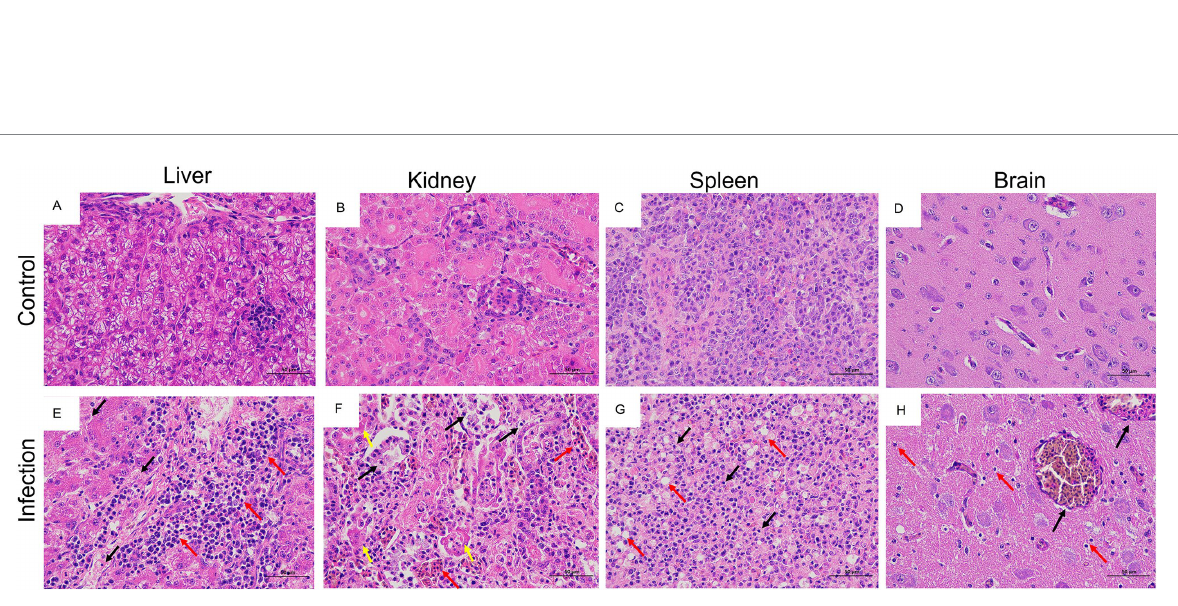
FIGURE 8 Histopathological changes in goslings, naturally infected and experimentally infected with GoAstV-GD2101. (A–D) Healthy liver, kidneys, spleen, and brain from the control group. (E) A slight loosening of hepatocyte cytoplasm (black arrow) and hepatocyte swelling (red arrow; H&E). (F) Severe exfoliation of renal tubular epithelial cells (black arrow), increased eosinophilia of the cytoplasm and a lumen filled with urate deposits (yellow arrow), small area of renal tubulointerstitial stasis dilatation (red arrow; H&E). (G) The nuclei of the spleen cells were pyknotic, deeply stained, or fragmented (black arrow), along with a large number of macrophages red arrow; H&E). (H) Limited congestion and dilation of blood vessels in the brain (black arrow) and diffuse proliferation of microglial cells (red arrow;